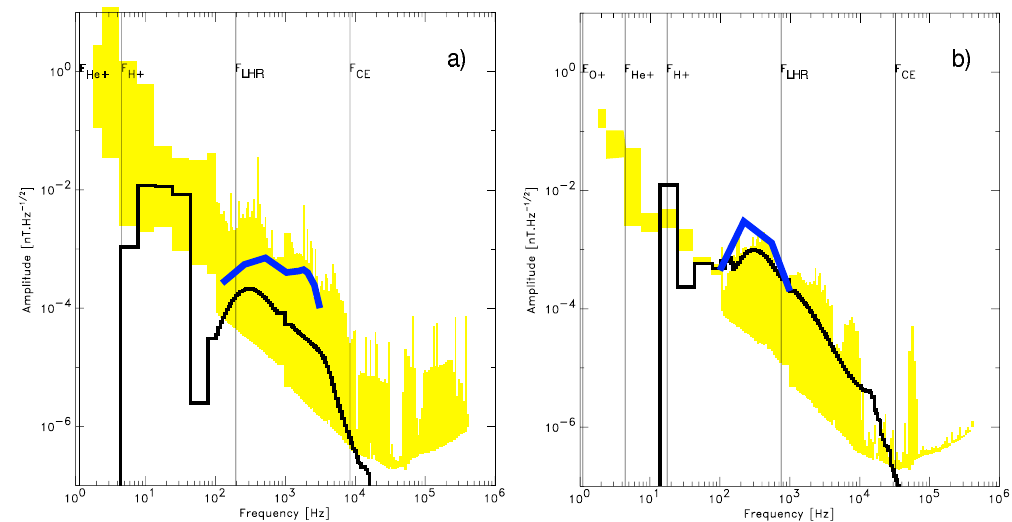
Fig. 8. Amplitude spectra recorded (blue line) on board (a) GEOS-1 and (b) OGO-5 compared with the averaged amplitude spectra modelled (heavy black line) for similar geophysical conditions. The measured spectra recorded by DE-1 are shown with yellow